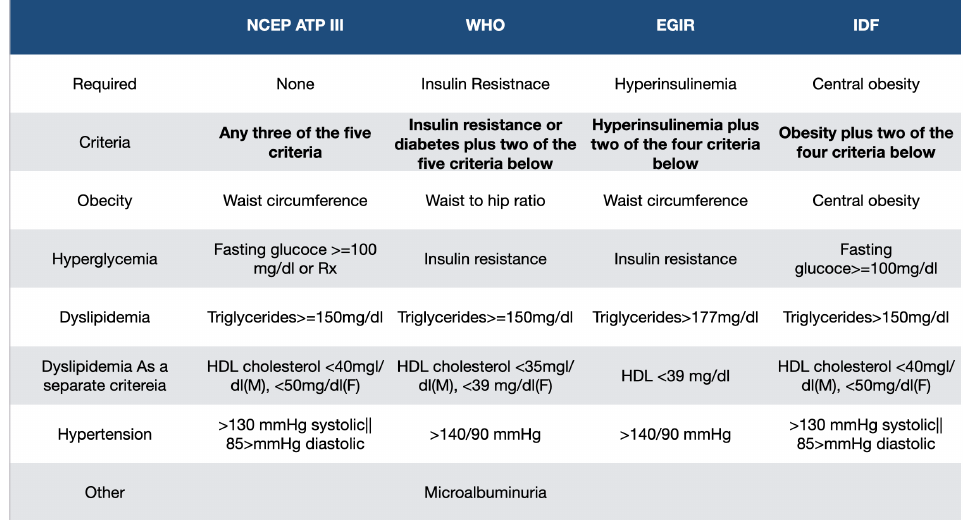
Figure 15. MetS guidelines and